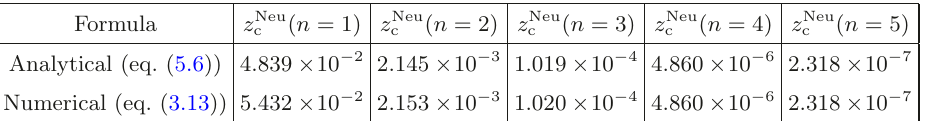
Table 4 . Spinning exotic compact objects with reflective Neumann boundary conditions. We use the same physical parameters as in table 3. In the physically interesting z c ≪ 1 regime of radii { z analytical